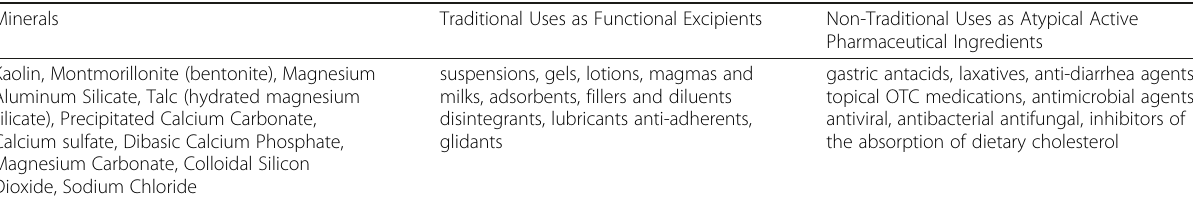
Pharmaceutical Ingredients suspensions, gels, lotions, magmas and gastric antacids, laxatives, anti-diarrhea agents, milks, adsorbents, fillers and diluents topical OTC medications, antimicrobial agents: disintegrants, lubricants anti-adherents, antiviral, antibacterial antifungal, inhibitors of glidants the absorption of dietary